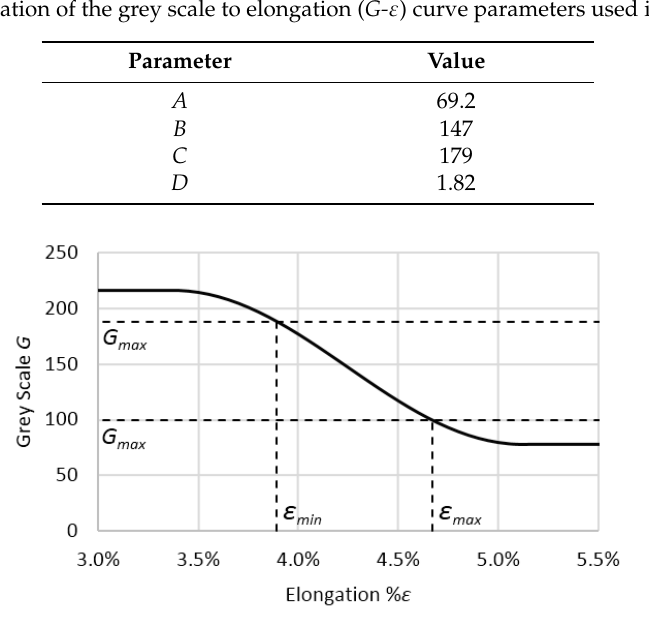
Figure 3. Grey scale to elongation relationship. Dashed lines represent limits of the function used in further calculations.